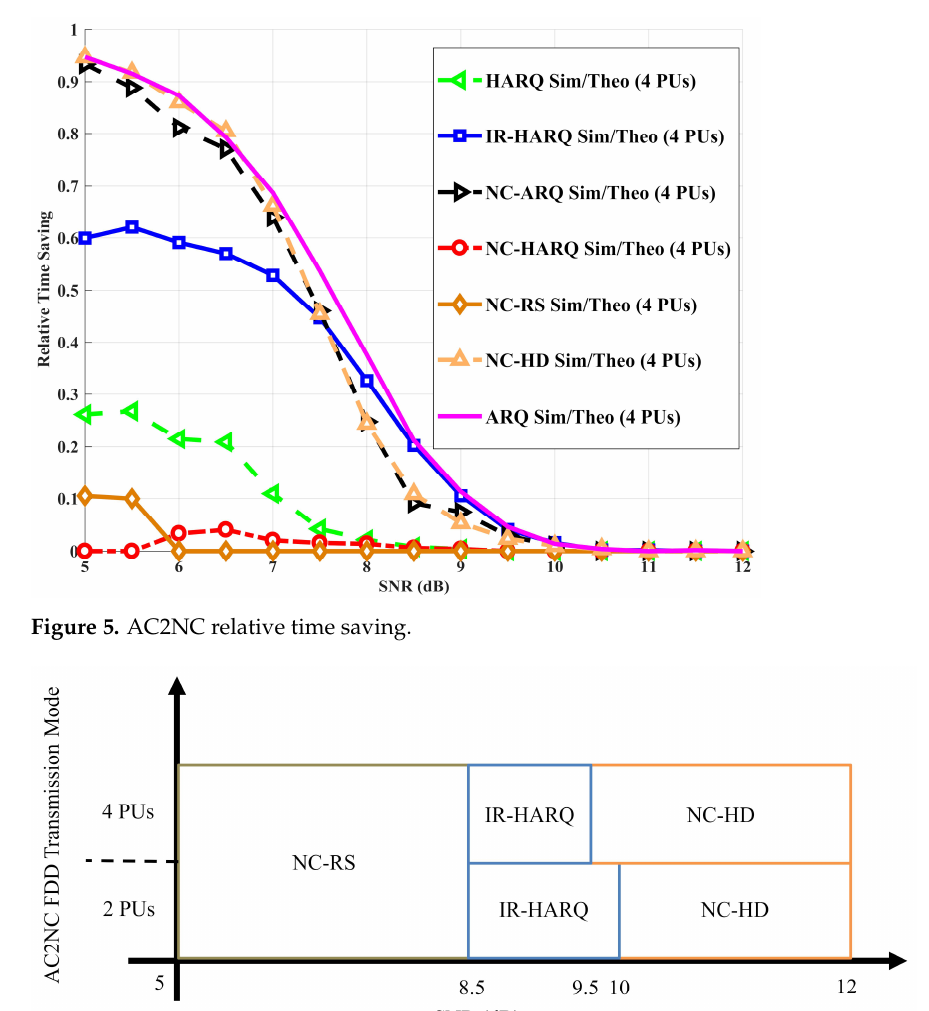
Figure 6. AC2NC FDD transmission mode.